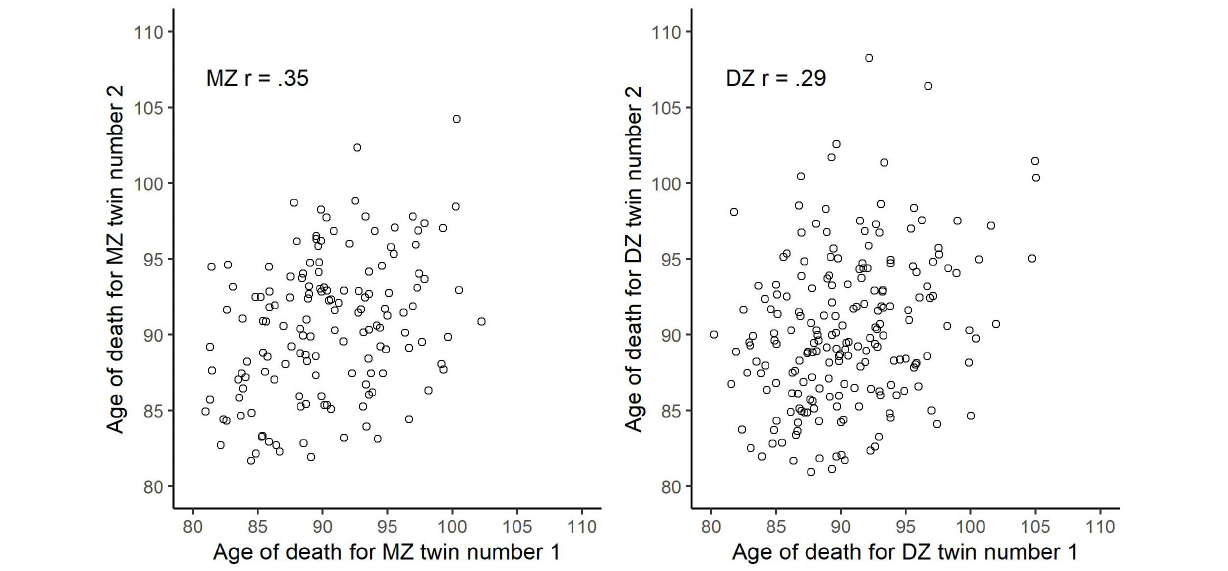
death, as stratified by zygosity, in Table 2 . Next, fitting an ACE model to the data, using maximum likelihood estimator, provided the following estimates: A 0 . 5 = 0.341, 95% CI [ − 0.03, 0.72]; C 0 . 5 = 0.48, 95% CI [0.27, 0.69]; E = 0.65, 95% CI [0.51, 0.75].